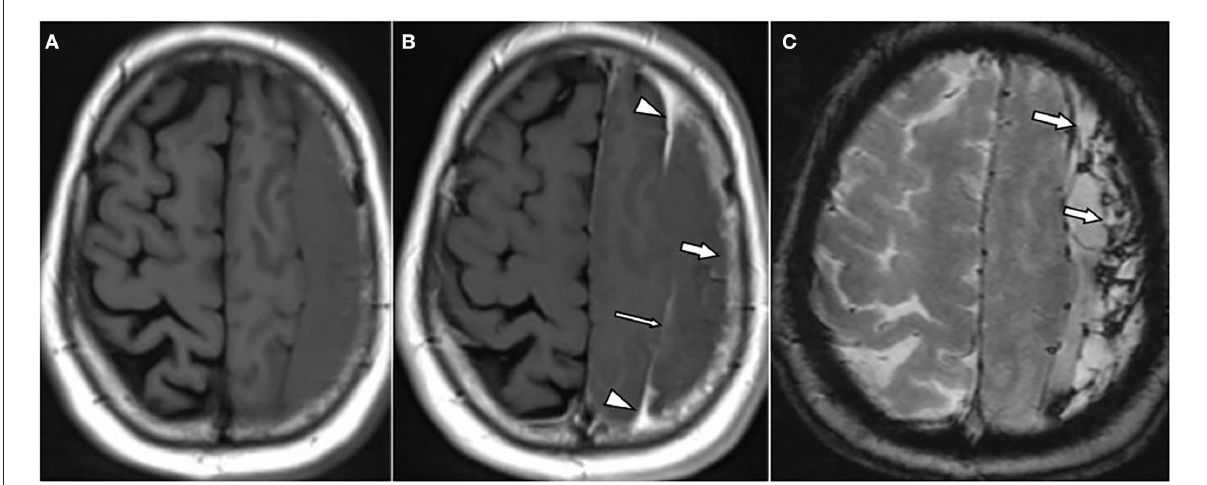
FIGURE1 A 62-year-old male patient with chronic subdural hematoma (cSDH) over the left convexity. Axial T1w images pre (A) and post (B) contrast administration as well as an axial T2 * w gradient echo image (C) . There is enhancement of the inner [ (B) : thin arrow] and outer membrane [ (B) : arrow] as well as a roughly triangular, spandrel-like contrast enhancement at the borders of the hematoma [ (B) : arrowheads]. On T2 * -GRE (C) , there is hemosiderin staining adjacent to the dural surface and septa [ (C) : arrows].